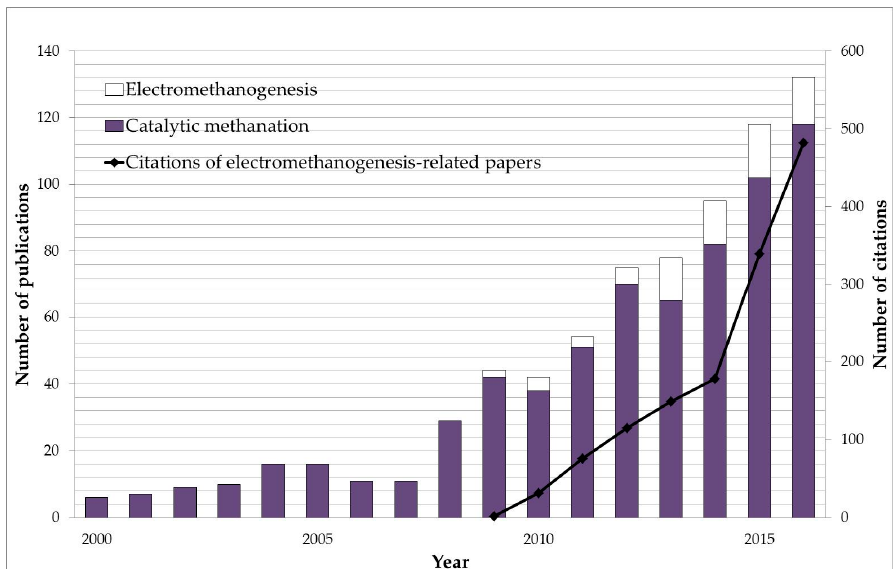
Figure 1. Scientific publications dealing with methane production catalyzed by minerals (catalytic methanation) or microbes (electromethanogenesis) published from 2000 to the beginning of 2017. Additionally, the number of citations of electromethanogesis-related papers is also shown. This data was extracted from Scopus database using the keywords “methane production bioelectrochemical systems”, “electromethanogenesis”, “methane bioelectrosynthesis”, bioelectrochemical methane production”, “electromethanosynthesis”, “methanogenesis bioelectrochemical system” for electromethanogenesis and “catalytic methanation” for catalytic methane formation. (Search date: 4 January 2017).